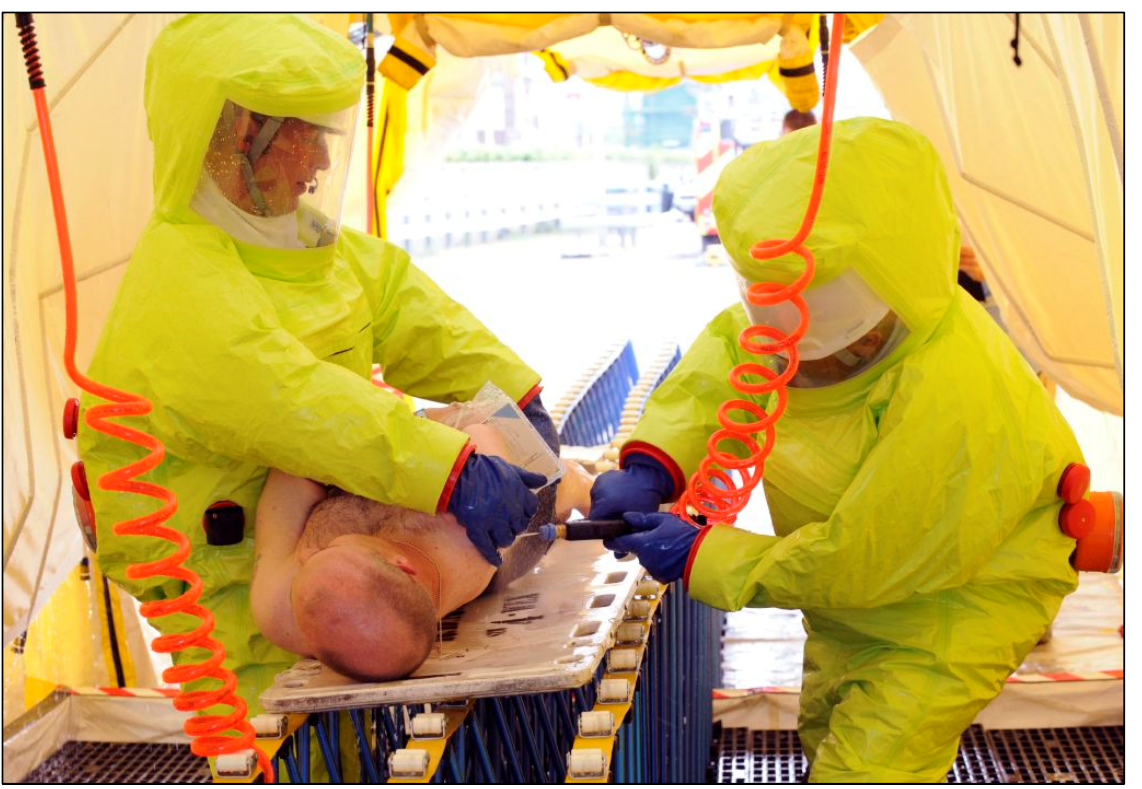
Figure 3. A non-ambulant casualty undergoing clinical decontamination during an emergency exercise, London, 2010.